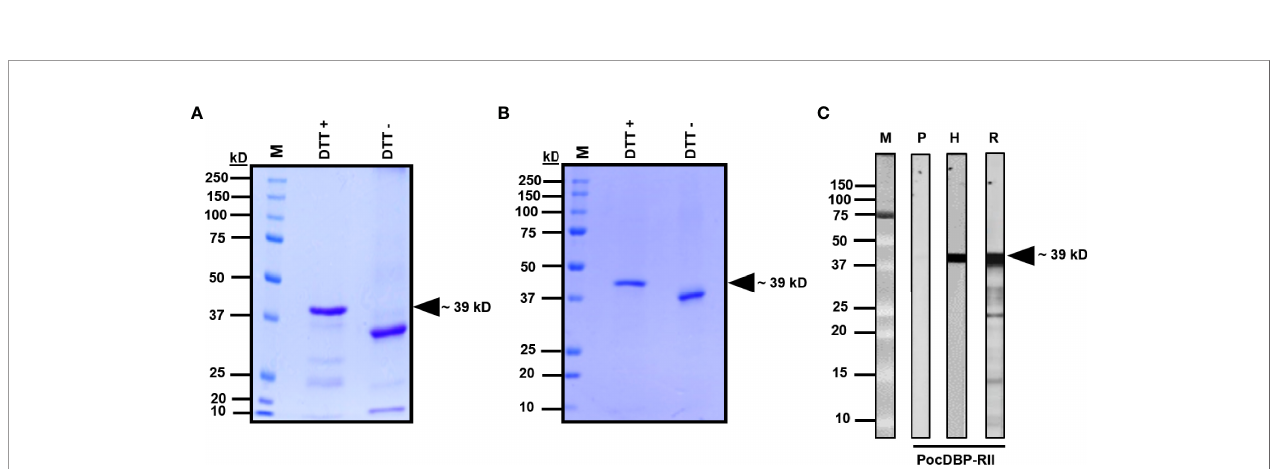
FIGURE 2 | Three-dimensional structure of DBP-RII. The electrostatic surfaces of (A) PvDBP-RII and (B) PocDBP-RII with positive (blue) and negative (red) charges are shown.